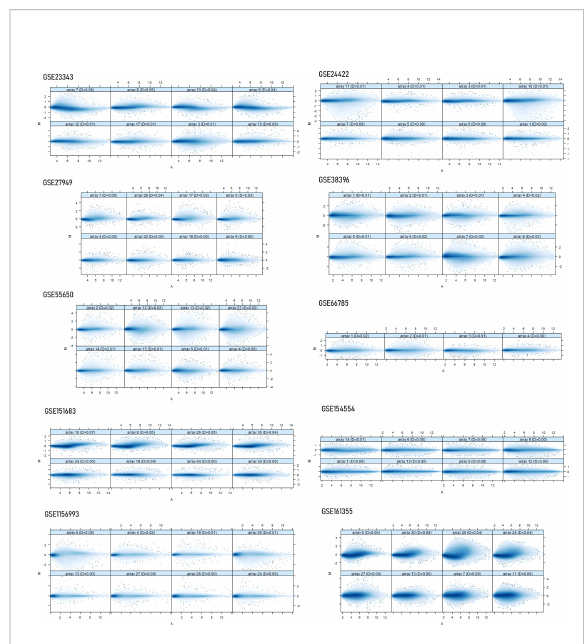
FIGURE 1 The normalization and the quality array metrics are represented by the MA plots showing the log intensity ratio (M) vs. log intensity averages (A). Usually, the mass of distribution in the MA plot is likely to be intense along the M = 0 axis.